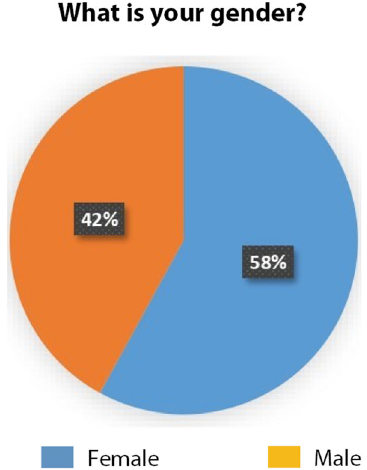
Fig. 4 Respondents gender distribution (Source: the